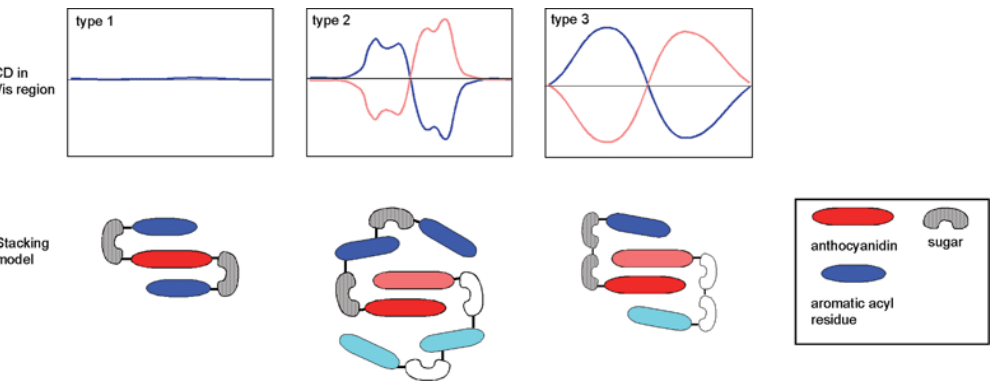
Figure 13. Acylated anthocyanins: discrimination of intramolecular co-pigmentation (type 1) and self-association (types 2 and 3) by circular dichroism (pink or blue CD spectra depending on the chirality of the stacks). From [34] with permission of the Royal Society of Chemistry .